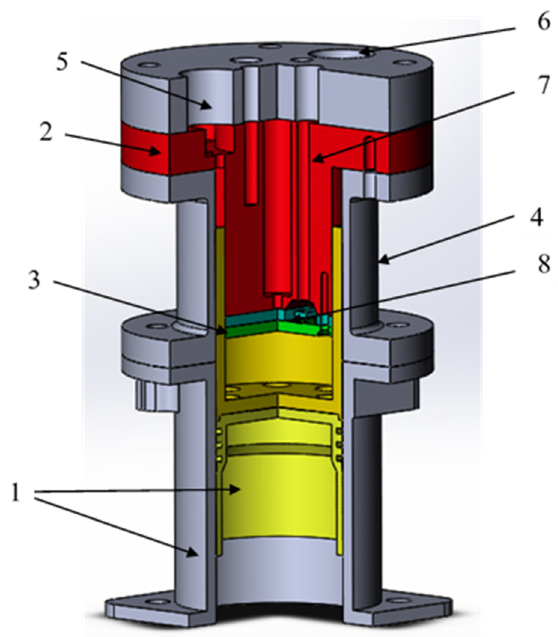
Figure 5. Three-dimensional (3D) image of the layout of the test model of a piston hybrid machine. 1—piston unit of the base compressor; 2—inner cylinder; 3—annular П -shaped protrusion of the piston; 4—outer cylinder; 5—pump cavity suction lines; 6—pump cavity discharge lines; 7—compressor section discharge lines; 8—valve body of compressor section.